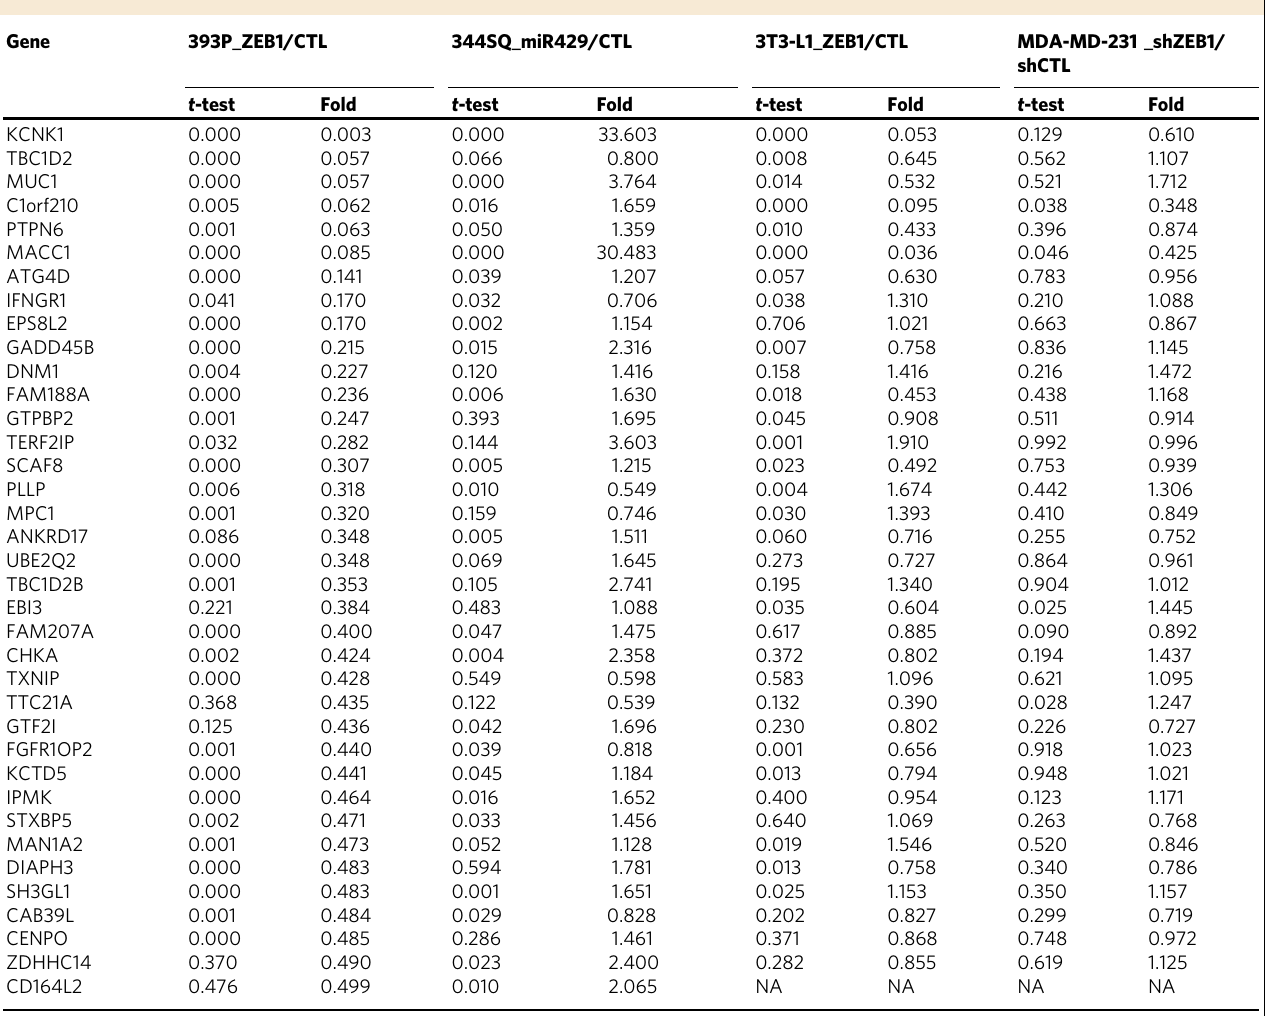
Table 2 Candidate ZEB1/CHD4/NuRD targets